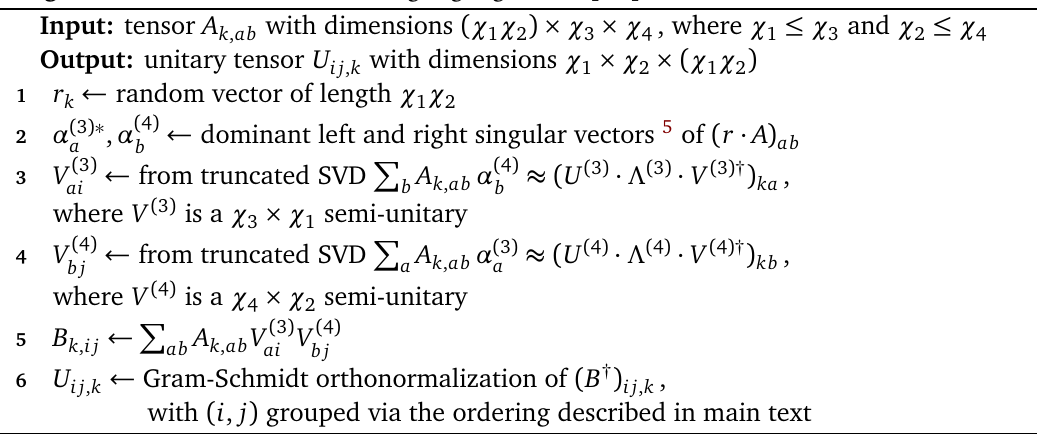
Algorithm 1: Fast tensor disentangling algorithm [ 25